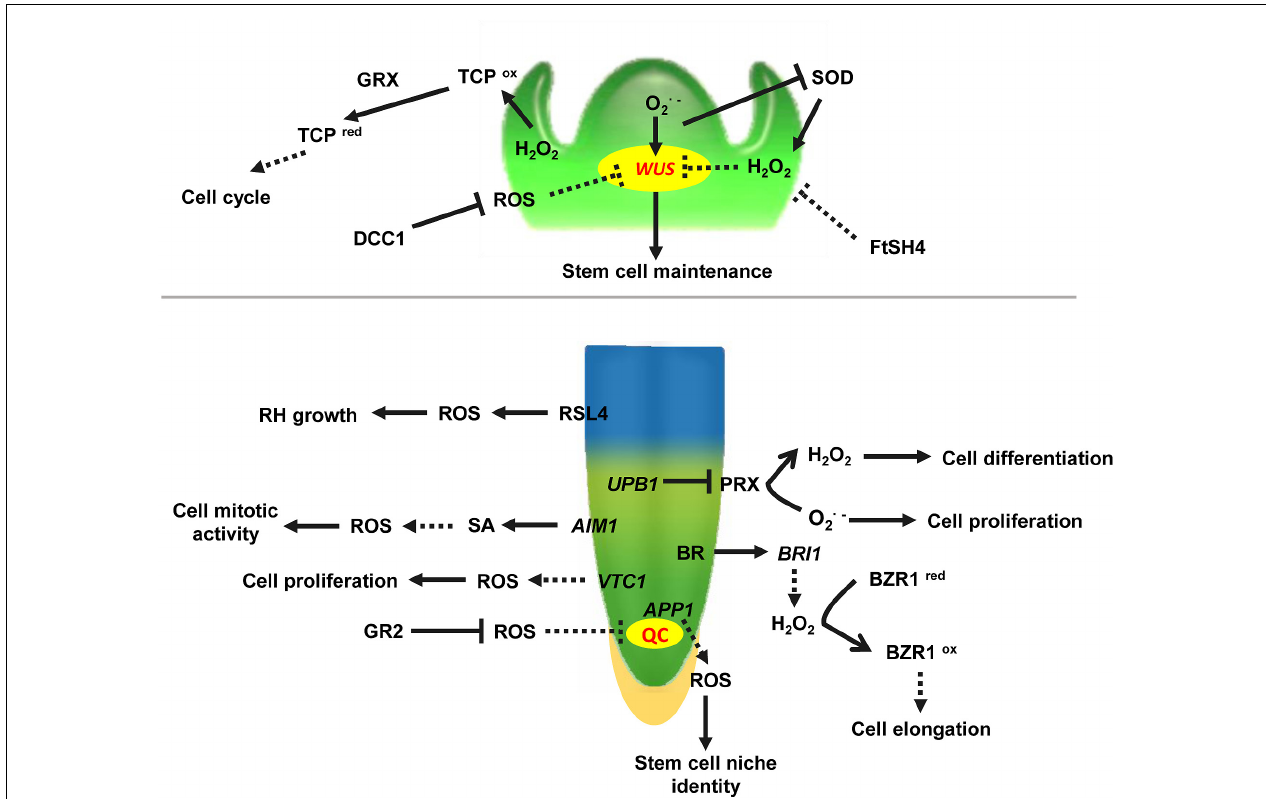
FIGURE 1 | ROS involved in vegetative apical meristem identity in the shoot apical meristem. WUS, WUSCHEL, a regulator maintaining stem cell identity in shoot apical meristem. O ·− 2 and H 2 O 2 activate and repress WUS activity to balance stem cell identity and differentiation, respectively. DCC1, a functional thioredoxin that inhibits the accumulation of ROS in the cell, and creates conditions for SAM formation. TCP, TEOSINTE BRANCHED/CYCLOIDEA/PCF, a transcriptional regulator of the cell cycle, is inhibited by higher ROS levels in the SAM. TCP ox (TCP in oxidated state)/TCP red (TCP in reduced state) can be regulated by GRX (Glutaredoxin). FtSH4 (also named AtFTSH4), an ATP-dependent mitochondrial protease, associated with internal oxidative stress and mitochondrial function in the SAM. UPB1, transcription factor UPBEAT1, plays an important role in maintaining O ·− 2 and H 2 O 2 balance in the RAM. RSL4, ROOT HAIR DEFECTIVE SIXLIKE 4, a bHLH transcription factor, activates ROS-related gene expression and regulates root hair elongation. AIM1 , ABNORMAL INFLORESCENCE MERISTEM , regulates ROS levels via the SA synthesis pathway in the RAM. APP1 , Arabidopsis thaliana P-loop NTPase1 , controls ROS homeostasis in the stem cell niche (SCN) of the root tip. VTC1, an Enzyme Involved in Ascorbate Biosynthesis, regulates H 2 O 2 levels in the RAM. BRI1, BRASSINOSTEROID INSENSITIVE 1, and BZR1, BRASSINAZOLE-RESISTANT1, are modified by ROS. QC, quiescent center; BR, brassinosteroids; SA, salicylic acid; GR, glutathione reductase; RH, root hair. Arrows indicate positive regulation. Bars indicate negative regulation. Unbroken lines indicate direct regulation, and broken lines indicate unclear